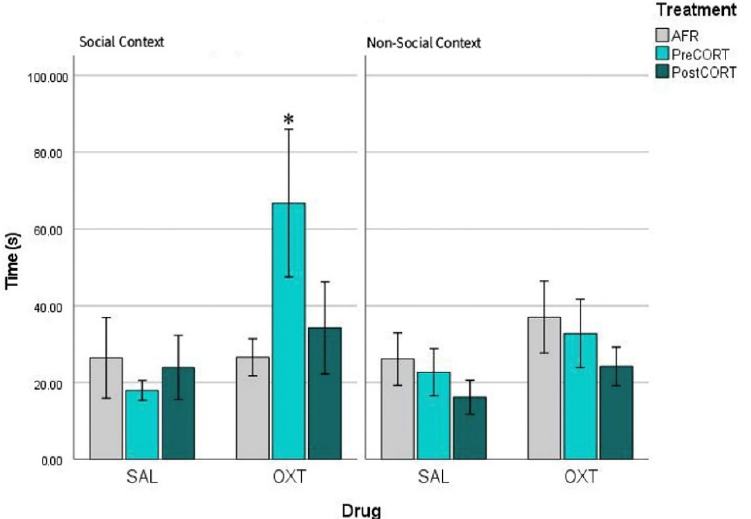
Figure 12. Comparison of licking rate exhibited by mice in a social vs. a non-social context. Mice that previously acted as Observers ( n = 8 for each group) in the Emotional Contagion assay (social context) and, to the aims of the formalin test (non-social context), received an injection of formalin (low dose, 0.2%) in a hind paw. Inspection of the results showed how oxytocin administration had only marginal or negligible effects in a non-social context. In contrast, a specific increased sensitivity to drug effects emerged in the social context. Again, this increased drug sensitivity was specific for the PreCORT subjects (* p < 0.05). Error bars indicate mean ± SEM.